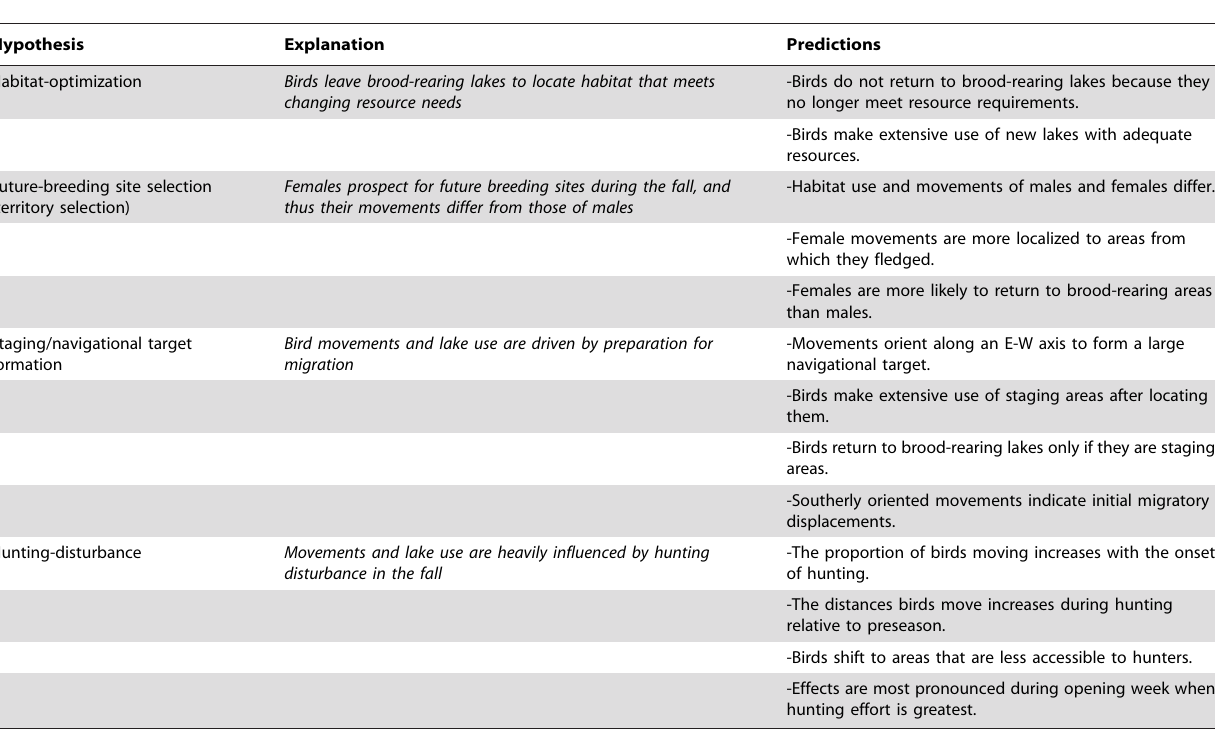
Table 1. Hypotheses we considered to explain movements and lake use of juvenile ring-necked ducks in the fall.